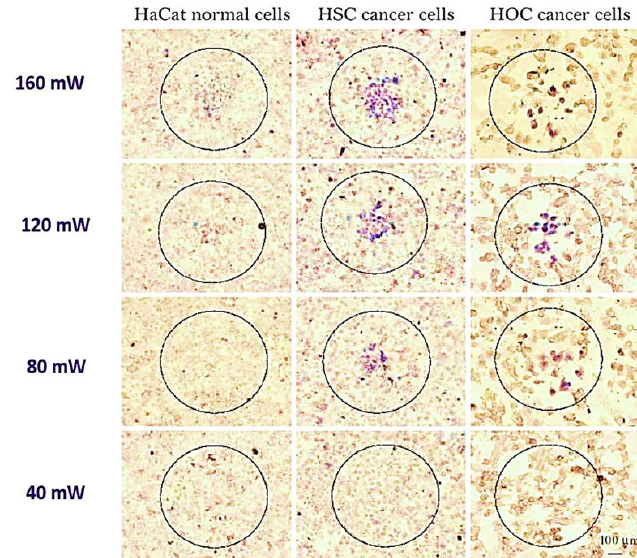
Figure 10. Optional photothermal therapy of incubated cancer cells with anti-EGFR/Au nanorods. The circles on the illustrations show the laser spots [70,77]. Reprinted with permission from ref. [70,77]. Copyright 2006 Journal of the American Chemical